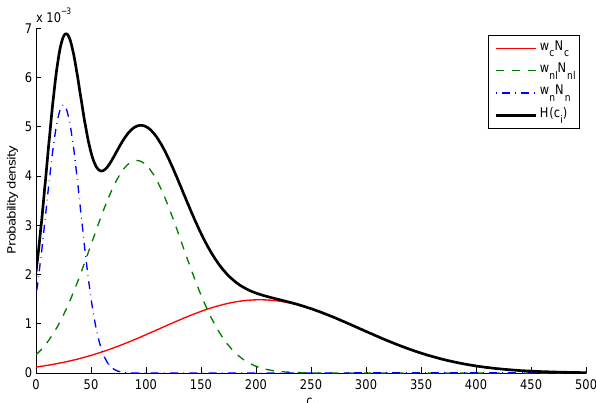
Figure 2. Histograms of a principal component modeled with three Gaussian distribution: change (c), non-labeling (nl), and non-change